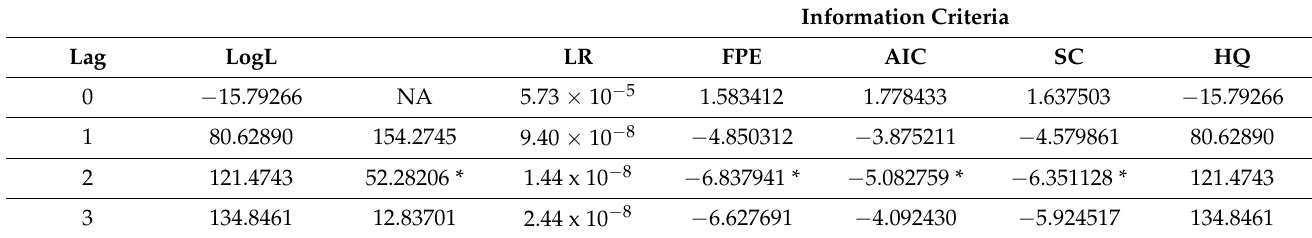
Table 2. Lag Interval Tests.